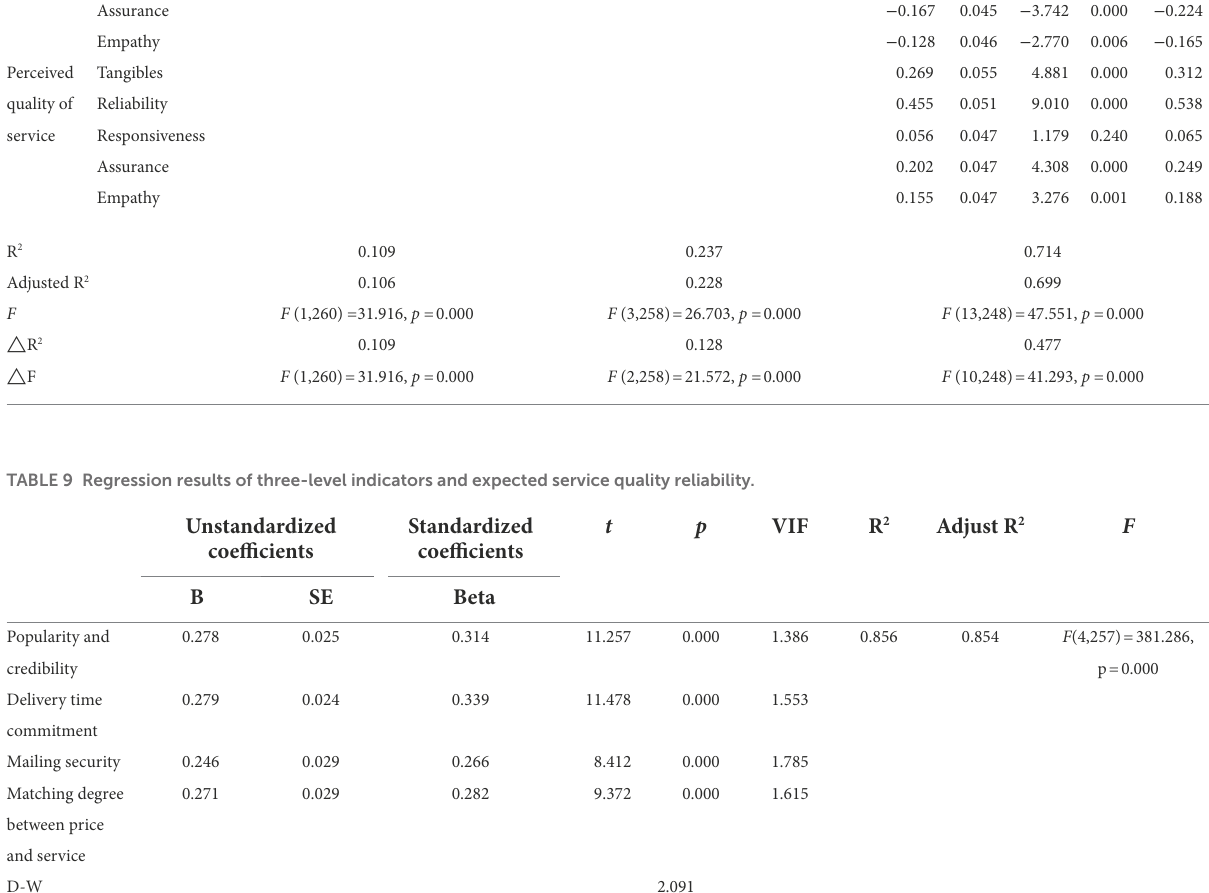
Tier 2: Add service quality (expectations/perceptions)